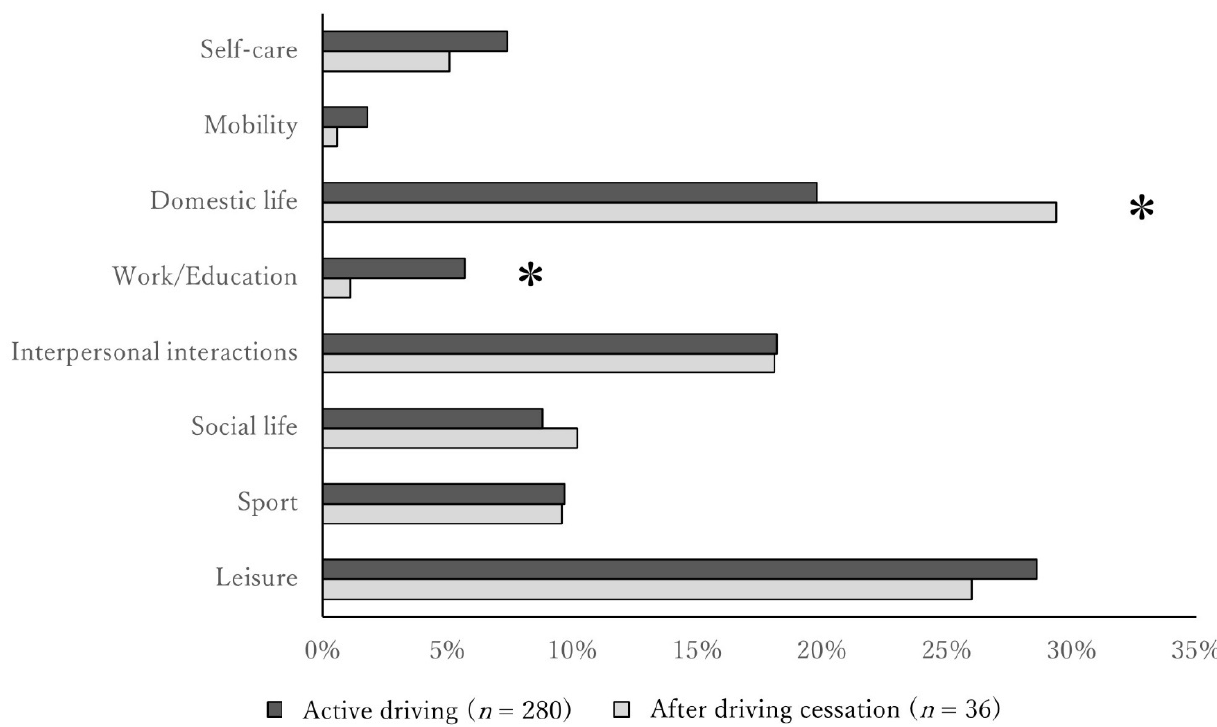
Figure 3. Comparison of meaningful activities between the active driving and the after driving cessation group in women. * p < 0.05, active driving group vs. after driving cessation group.